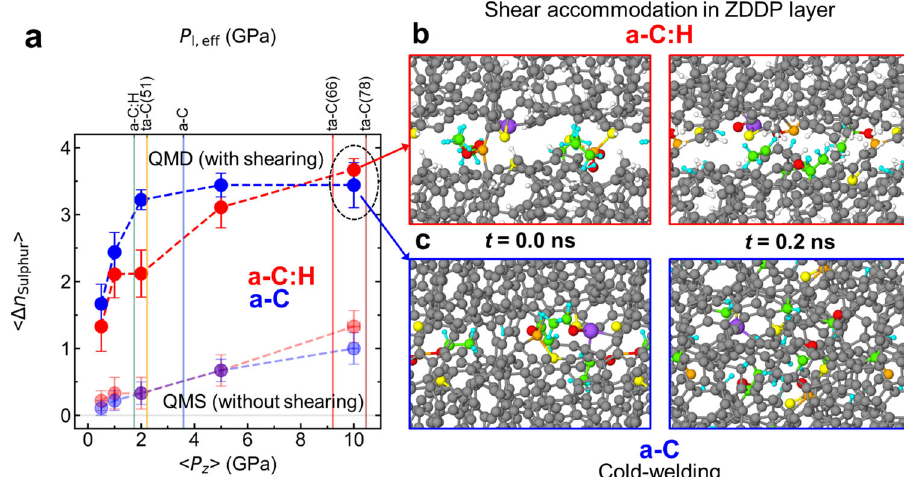
Fig. 7 DFTB3-MD sliding simulations of a-C:H and a-C in contact with a ZDDP molecule. A shear velocity of 30 m s − 1 is imposed along the x direction (cid:3) (cid:4) using Lees-Edwards boundary conditions. The system temperature is kept constant at T = 300 K. a Averaged numbers of sulphur atoms n Sulphur released from ZDDP to DLC after reopening the contact as a function of the contact pressure P z : The error bars represent standard error of the means. The vertical (cid:3) (cid:4) lines mark the effective local contact pressures P l ; eff for the fi ve experimental coatings (Fig. 1f). As references, n Sulphur for quasi-static calculations with no shear (Fig. 6h) are depicted with semi-transparent markers. Representative snapshots of DLC surfaces at P z = 10 GPa for b a-C:H and c a-C. The left and right pictures in b and c show con fi gurations at t = 0.0 and 0.2 ns, h n i on the vertical axis represent the average number of bonds S (cid:3) C between sulphur and DLC carbon atoms that remain intact after reopening the contacts. Our simulations reveal that the formation of S − C bonds is the most dominant chemical reaction, in i increases agreement with our XPS results (Fig. 2). While h n S (cid:3) C ≤ 10 GPa), the pressure dependence of h n i in with P (0 : 5 ≤ P z z S (cid:3) C a-C:H and a-C is almost identical. For both DLC surfaces, chemical reactions of ZDDP follow the scenario described in ≲ 2 GPa, most ZDDP molecules chemisorb without Fig. 6. At P z decomposition (Fig. 6c) or decompose into two fragments by breaking of Zn − S bonds. A further increase of the contact pressure induces decomposition of ZDDP into atoms and small fragments.